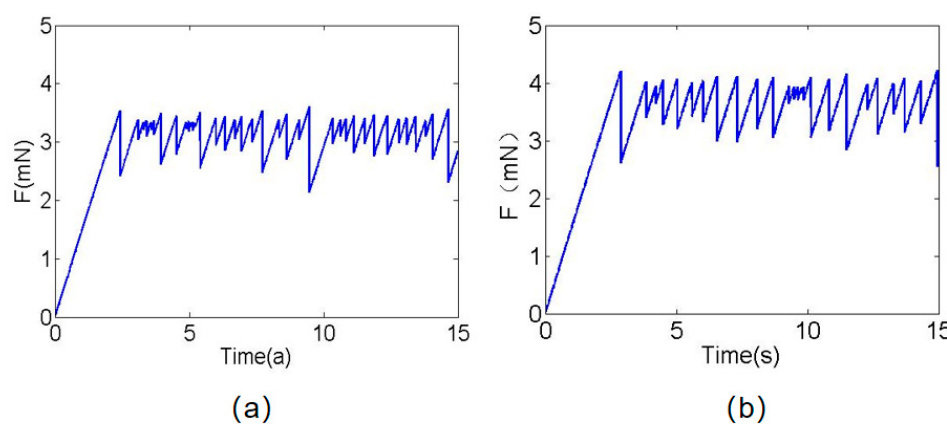
Figure 9. Friction curve change with time: ( a ) concrete surface friction curve at 50 ◦ C, and ( b ) concrete surface friction curve at 100 ◦ C.